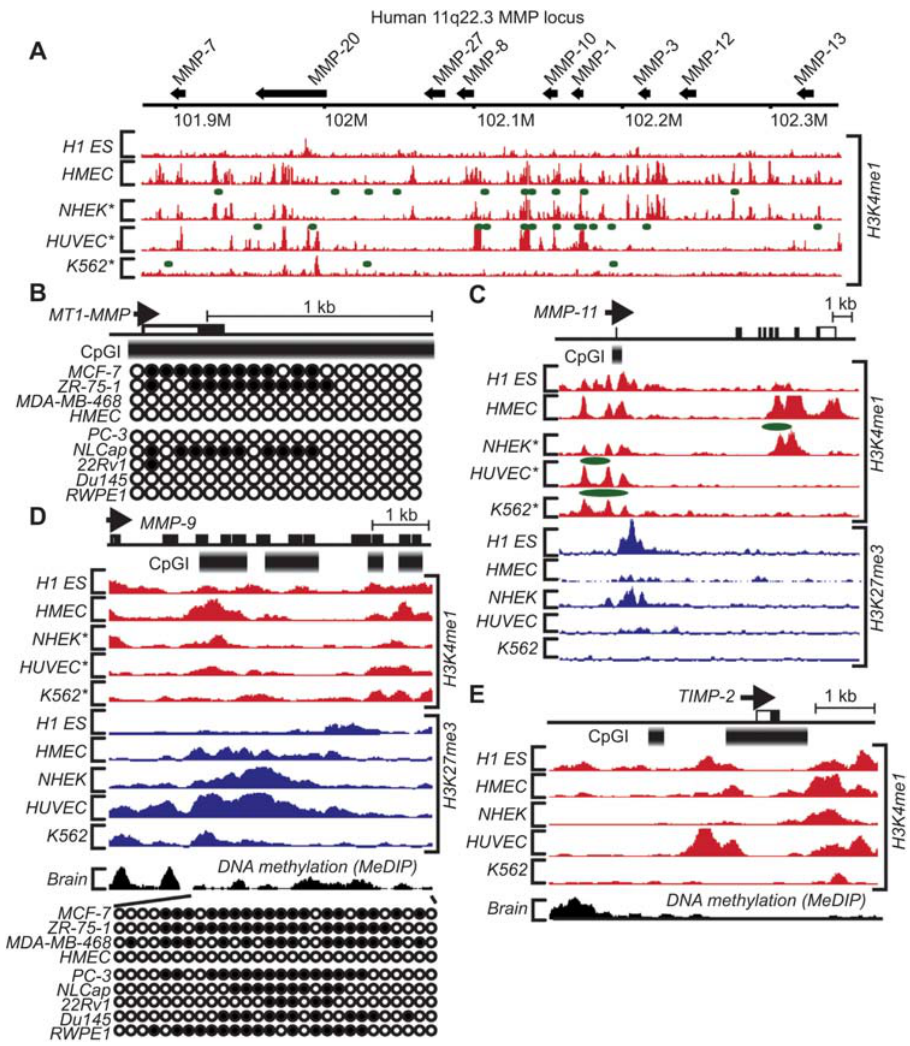
Figure 2 Epigenetic signature of the selected MMPs and TIMP-2 in normal and cancer cells. The H3K4me1 and H3K27me3 methylation profiling data of human embryonic H1 stem cells (H1 ES), mammary epithelial cells (HMEC), normal epidermal keratinocytes (NHEK), umbilical vein endothelial cell (HUVEC) and leukemia cells (K562) are derived from the ENCODE database (53, 65–67). The DNA methylation data of breast carcinoma cells (MCF-7, ZR-75-1 and MDA-MB-468), HMEC, prostate car- cinoma cells (PC-3, LnCap, 22Rv1 and Du145) and normal prostate cells (RWPE1) are derived from (68). DNA methylation data of the frontal cortex gray matter from the human brain are derived from (118). Color peaks correspond to the enrichment levels of H3K4me1 (red) and H3K27me3 (blue) across the genome (66). Green color marks the POL2-association sites (66). *POL2 data are not available. (A) The 11q22.3 locus includes MMP-1, -3, -7, -8, -10, -12, -13, -20, and -27. The arrows show the size and the transcription orientation of the MMP genes. The numbers below the line show the coordinates in chromosome 11. (B) DNA methylation profiling of the MT1-MMP gene. Each circle represents the methylation data of the individual probe. Open and closed circles represent unmethylated and methylated sites, respectively (68). Open and closed bars correspond to the non-coding and coding regions of the gene, respectively. The arrowhead indicates the transcriptional start site. The thick gradient bar represents CpGI. The panels (C), (D) and (E) show the epigenetic signature of the MMP-9, MMP-11 and TIMP-2 genes, respectively. MeDIP, methylated DNA